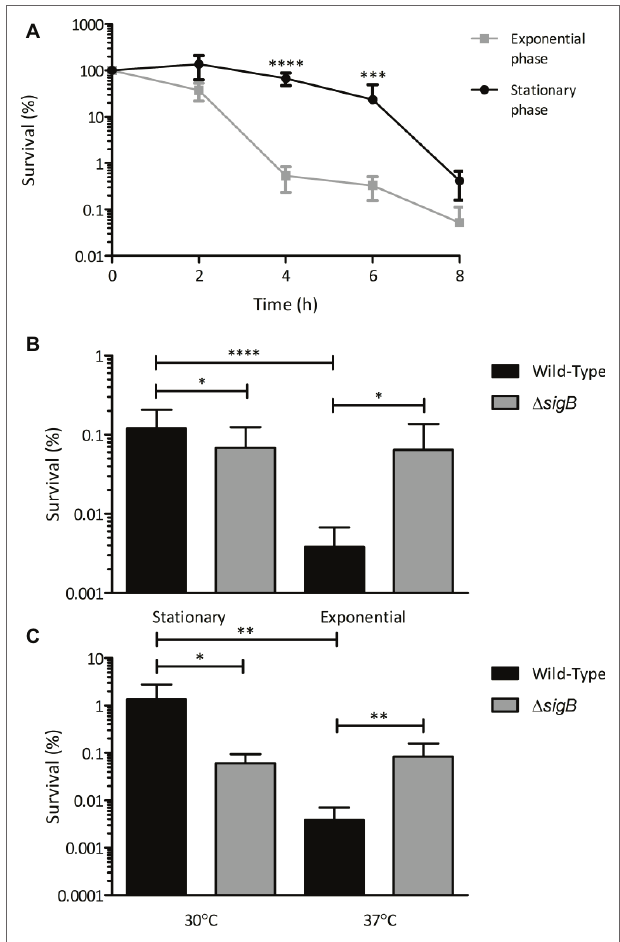
FIGURE 1 | Sensitivity of L. monocytogenes to visible light is affected by growth phase and temperature. Cultures were grown to the desired growth phase in BHI broth at the appropriate temperature. Cells were centrifuged, washed once in PBS and resuspended in PBS to OD 600 1, and then exposed to 35 mW cm − 2 470 nm light for 8 h. Samples were taken at 0 h and at either 2 h intervals (A) or 6 h (B,C) and cfu/ml were calculated. Error bars represent SD from three technical replicates, plated in triplicate, of two independent replicates. Statistical significance was determined using either two-way ANOVA with Dunnett’s multiple comparisons test (A) or one-way ANOVA with Sidak’s multiple comparisons test (B,C) . (* p ≤ 0.05; ** p ≤ 0.01; *** p ≤ 0.001; **** p ≤